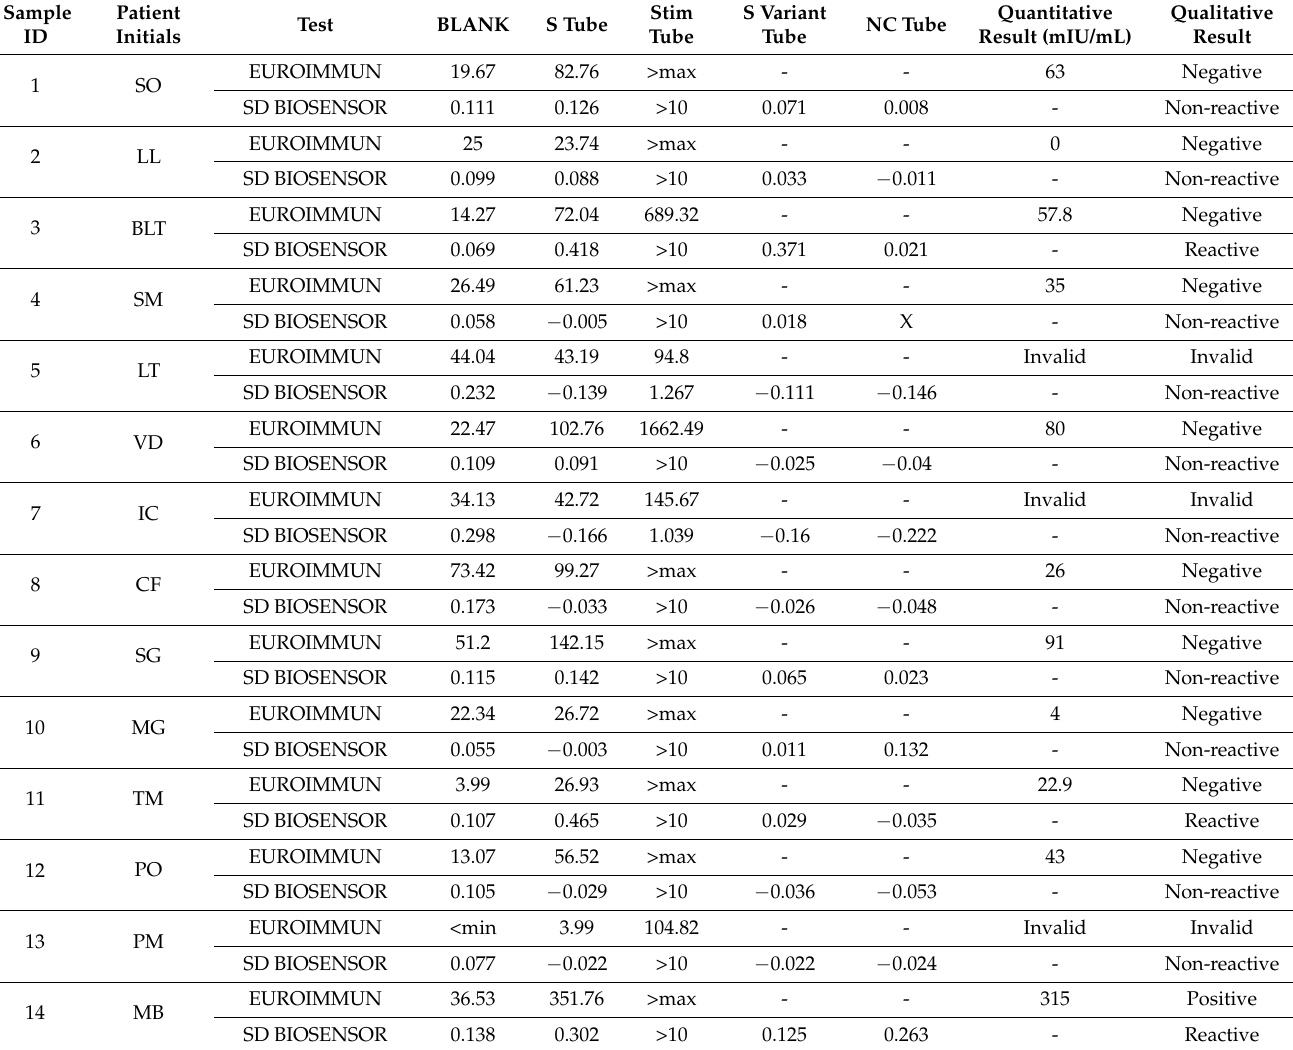
Table 1. Comparison of results (raw data, quantitative and qualitative) of the two